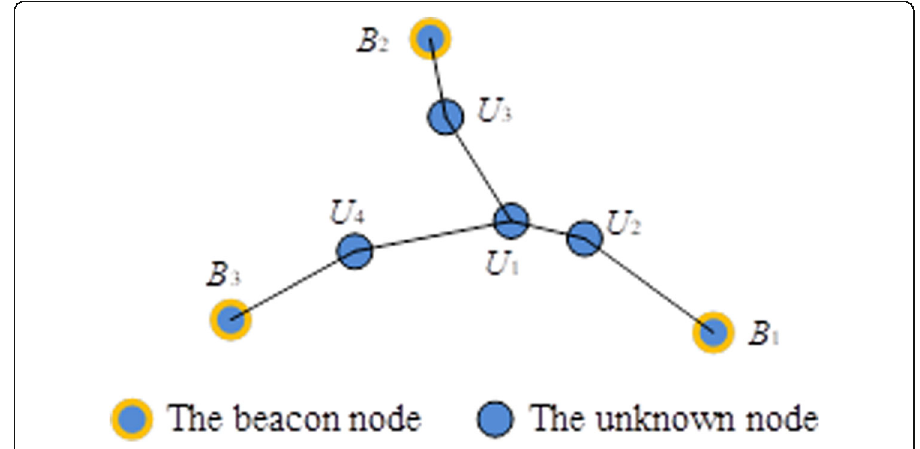
Fig. 2 A network with uneven distribution of the